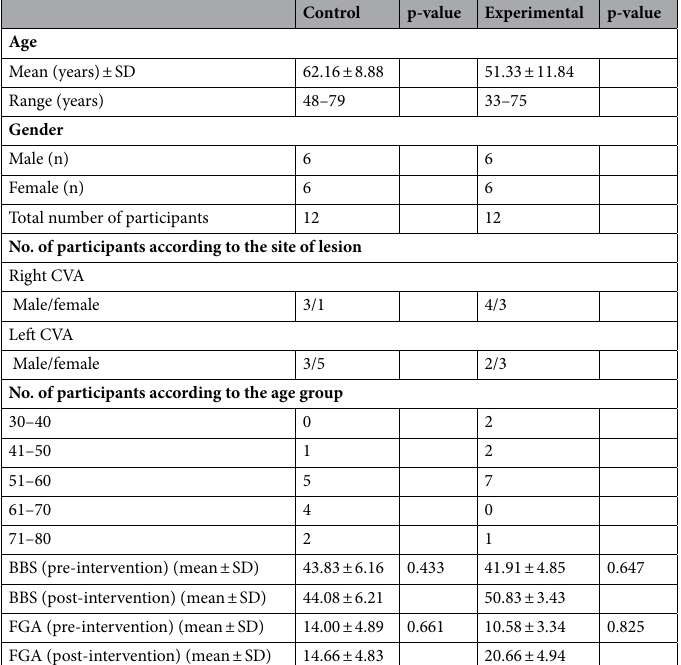
Table 1. Demographic data, mean values of dependent variables, and the p-values for the Shapiro–Wilk test of normality. BBS: Berg Balance Scale; FGA: functional gait assessment.